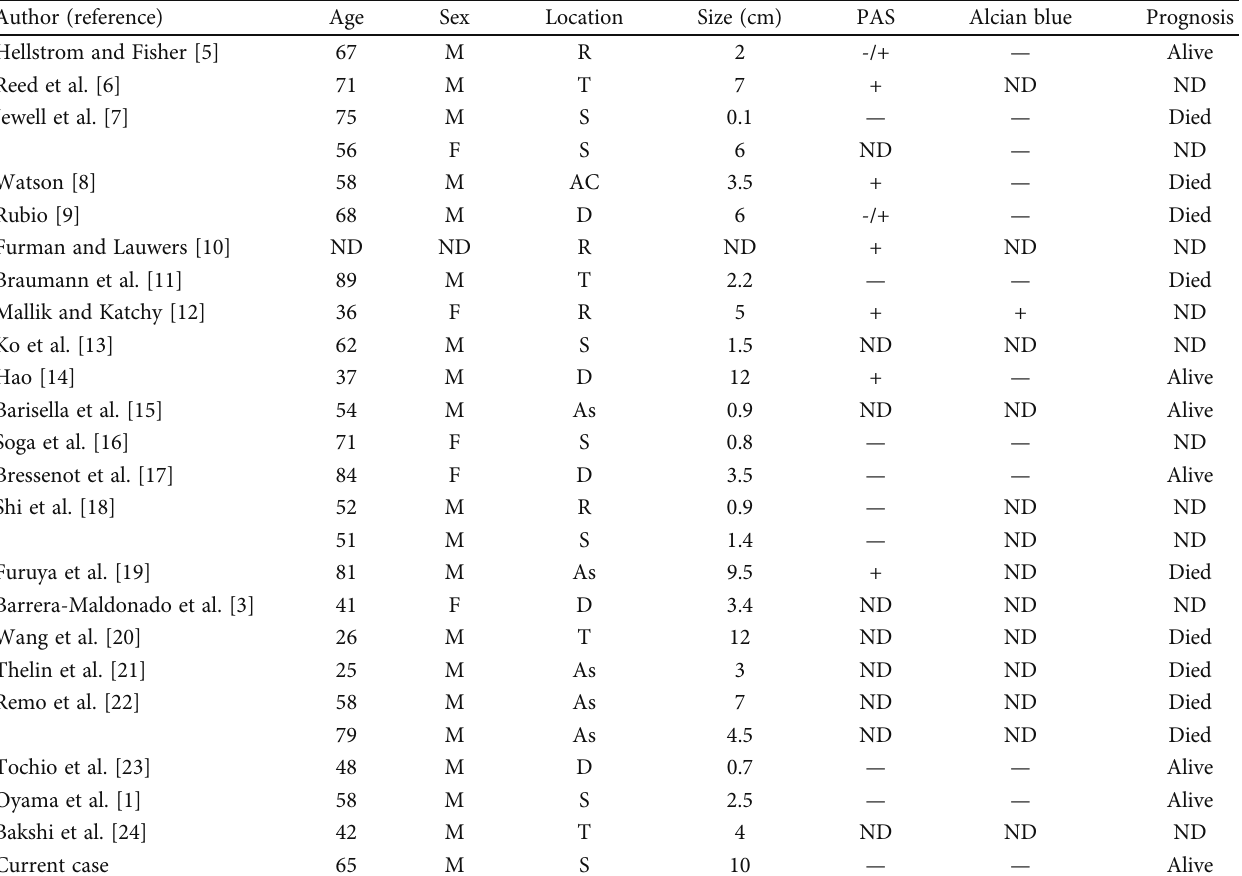
Table 2: Clinicopathological information for 25 clear cell adenocarcinomas of the